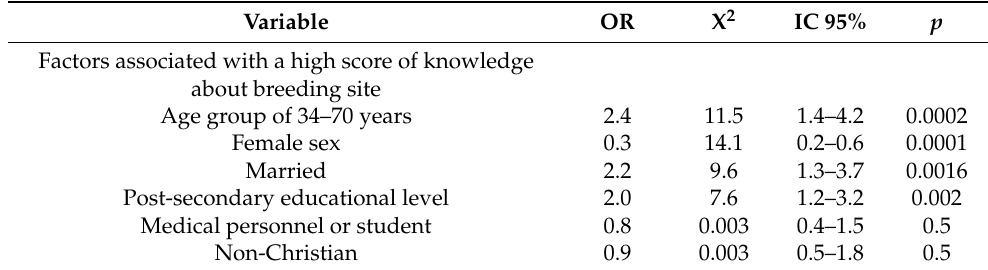
Table 6. Factors associated with a high level of knowledge about mosquitoes and MBVD in Kinshasa,